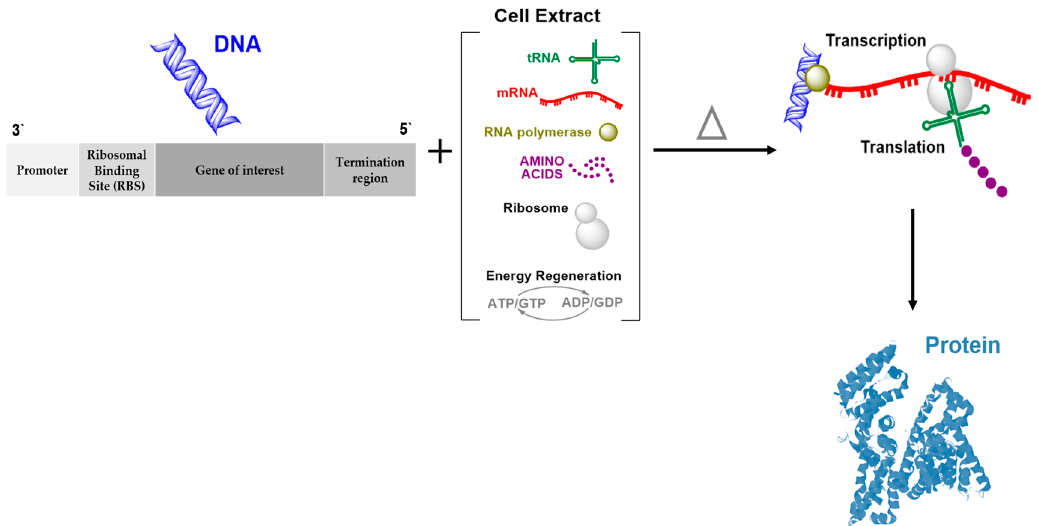
Figure 1. Cell-free protein expression system. The system requires a genetic template, e.g., DNA, that is composed of a promoter, a ribosomal binding site (RBS) which is either a Shine–Dalgarno or Kozak sequence, and a translation–transcription termination region. The reaction needs cell lysate and an energy regeneration system. Table 1. Comparing between cell-free and cell-based protein expression systems [4,9–16]. Cell-Based System